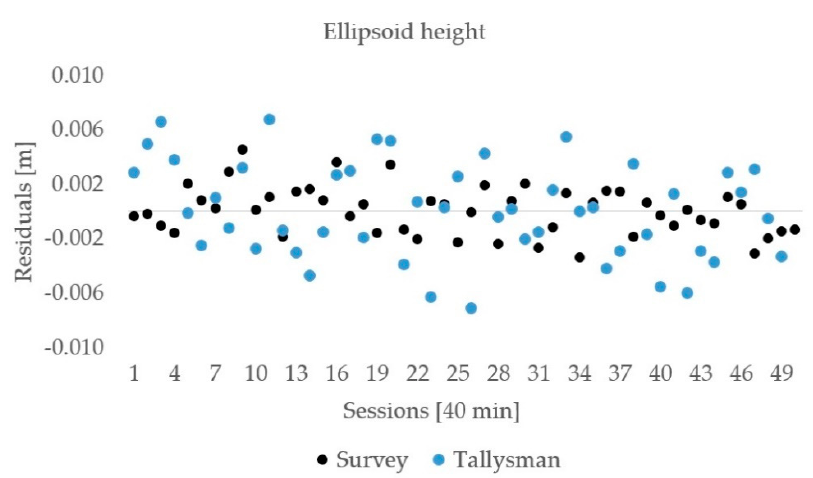
Figure 8. Ellipsoid height residuals for the low–cost uncalibrated antennas. Table 4. Horizontal distance statistics for the low–cost uncalibrated antennas.